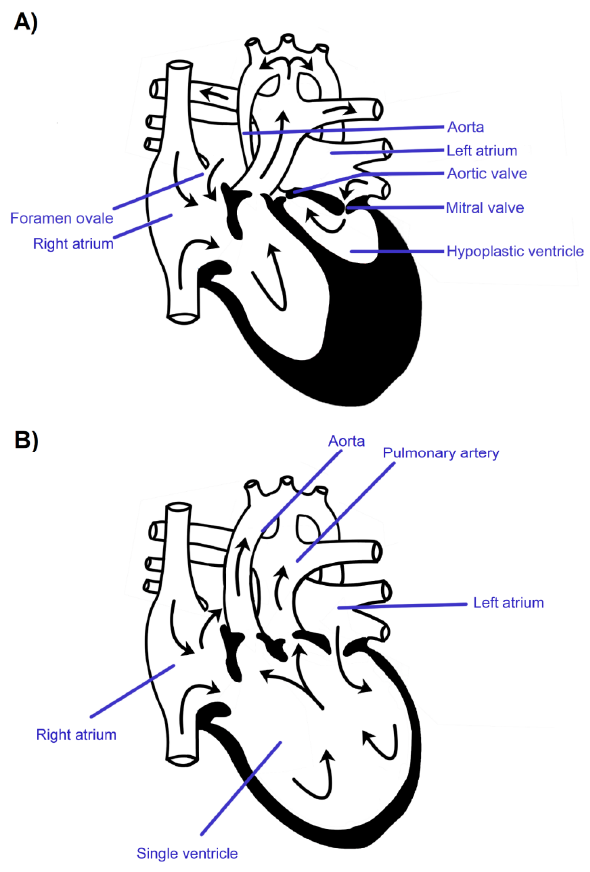
Figure 1. The schematic figure of fetal hypoplastic left heart syndrome ( A ) and anatomical single ventricle heart ( B ).